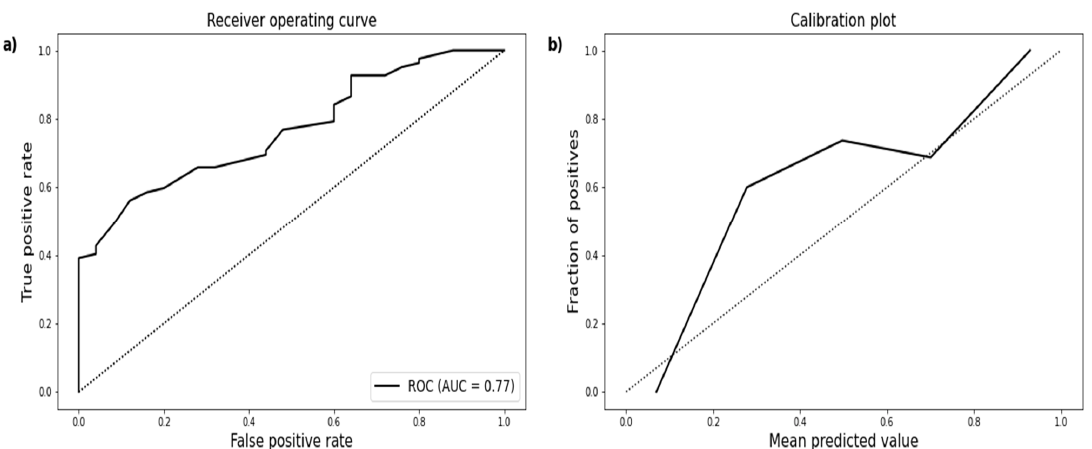
Figure 2. ( a ) ROC curve demonstrating an AUC of 0.77 (95% CI 0.68–0.85) for predicted SIRS. ( b ) Calibration plot showing the distribution of the observed SIRS and the corresponding prediction.